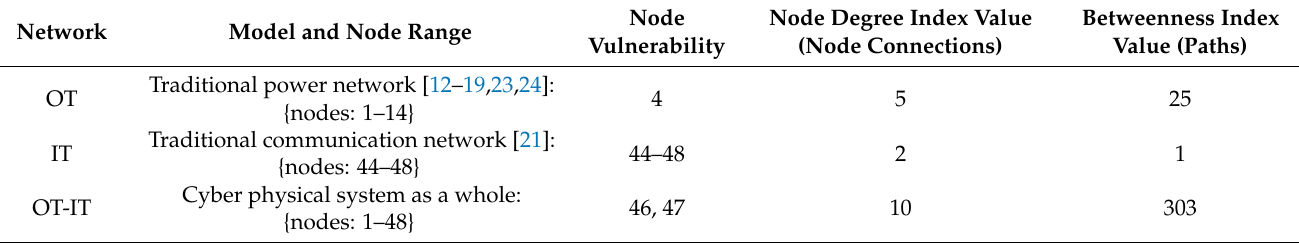
Table 4. Comparison of node vulnerability between